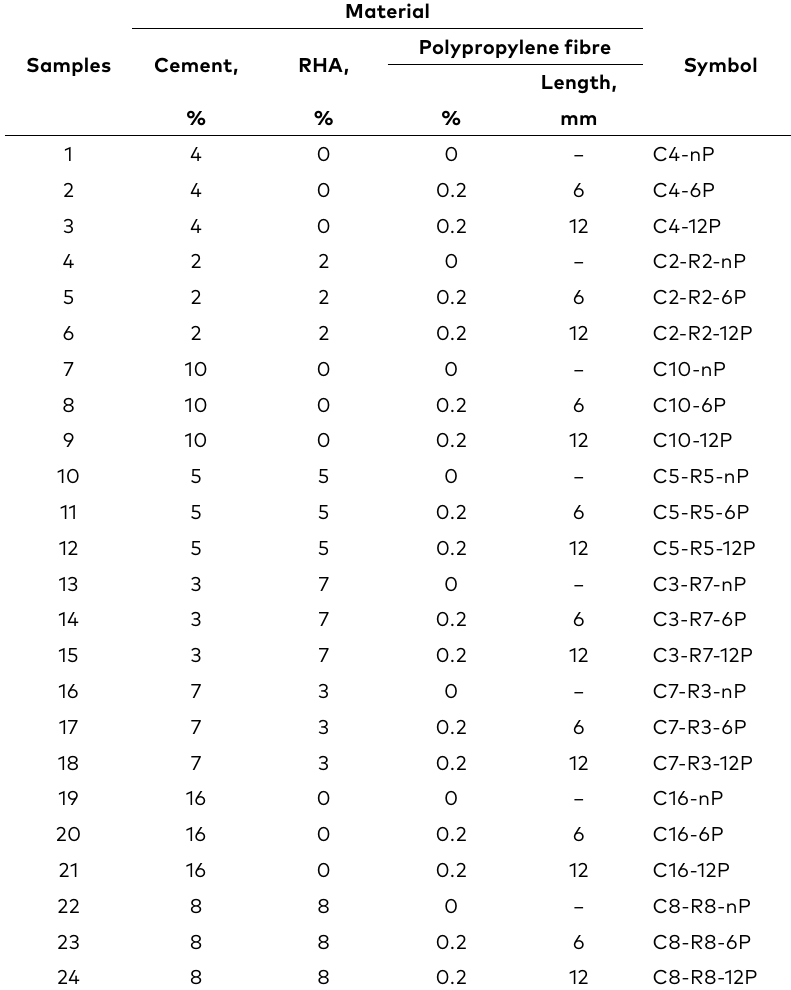
Table 4. Tests program and the used